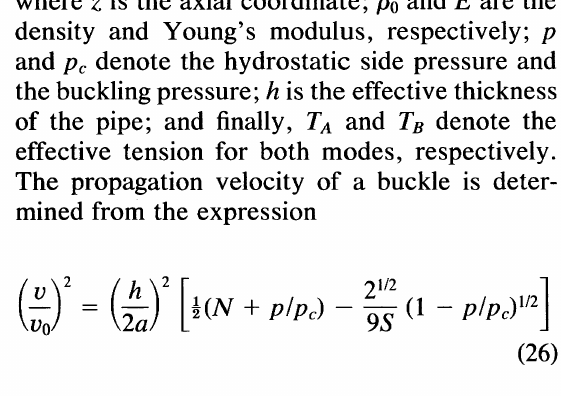
FIGURE 6 Toppling dominoes; c, wave velocity.